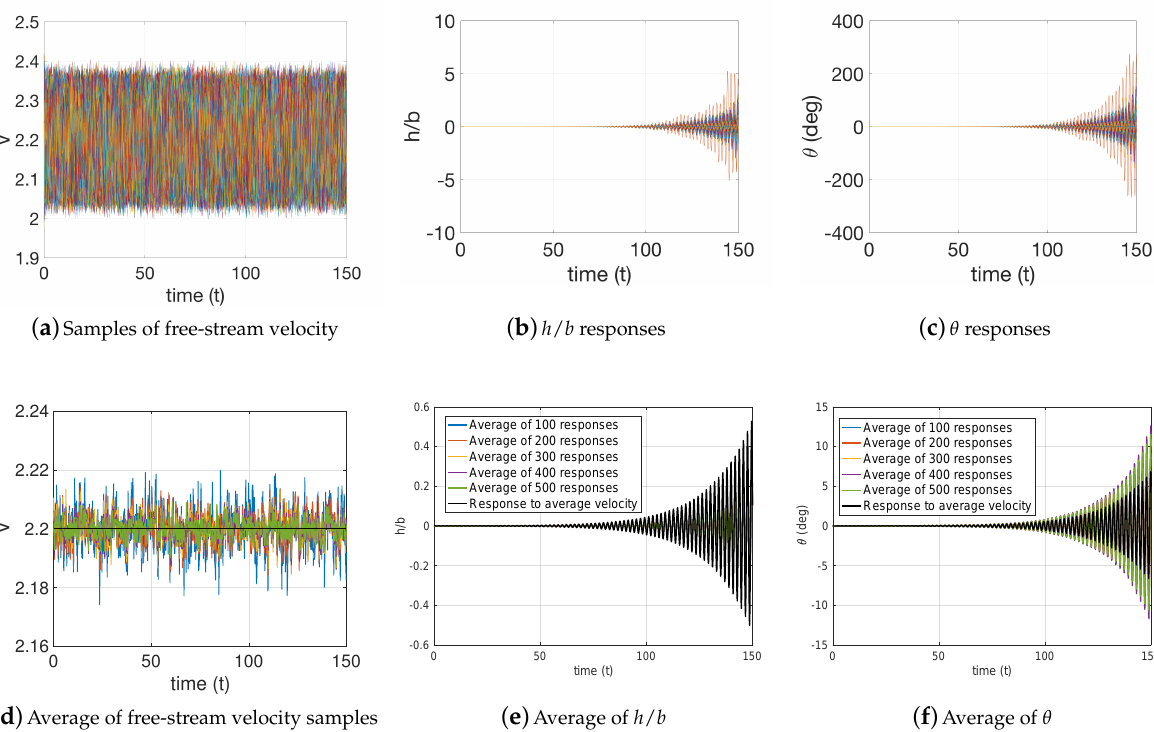
Figure 14. Illustration of law of large numbers with 500 samples for an unstable average velocity, for V ave = 2.2 for α = 5, and ∆ =